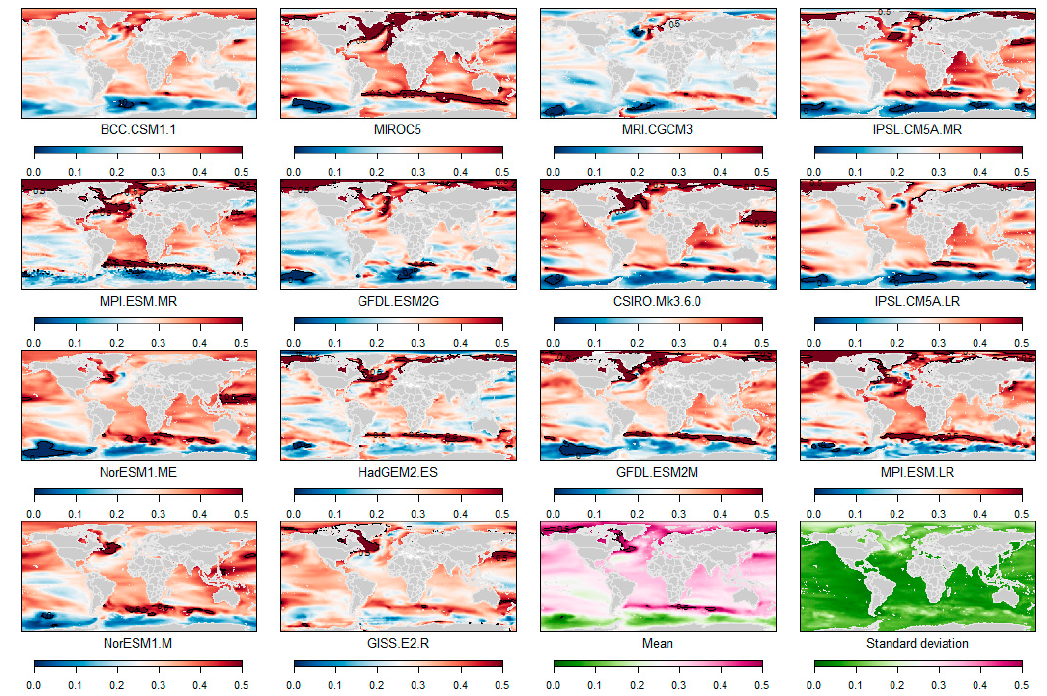
Figure 1. Sterodynamic sea-level changes (in m, for 2099 with respect to 1986–2005) for each climate model used in this study, their mean and standard deviation, for RCP8.5 and 2100. See Appendix A for RCP2.6 and RCP4.5.